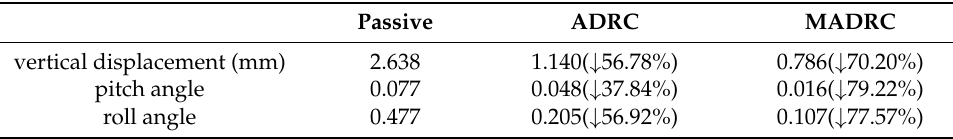
Table 2. Root-mean-square value of vehicle attitude under stochastic signals.